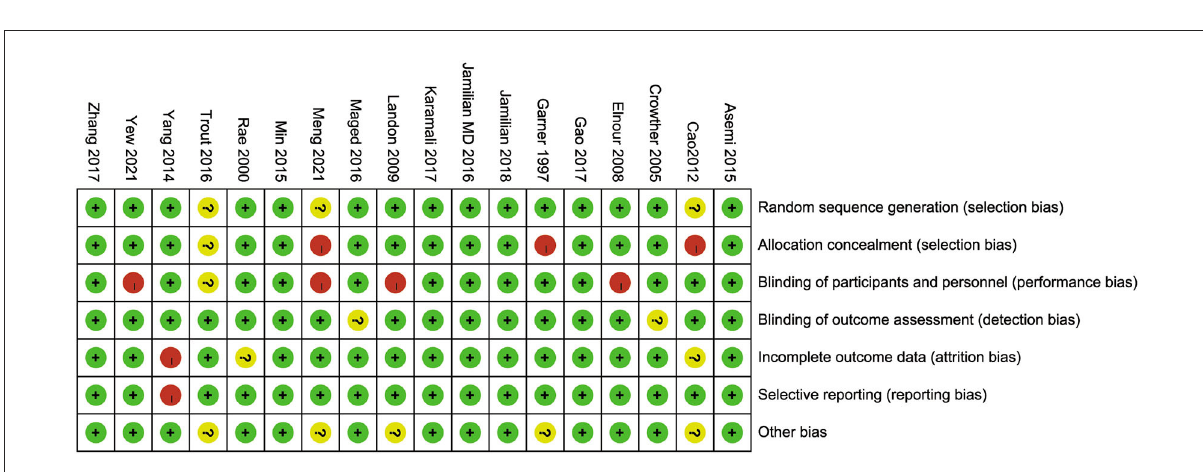
FIGURE3 Risk of bias of each included study was assessed using the risk of bias (RoB) tool of the Cochrane Handbook for Systematic Reviews of